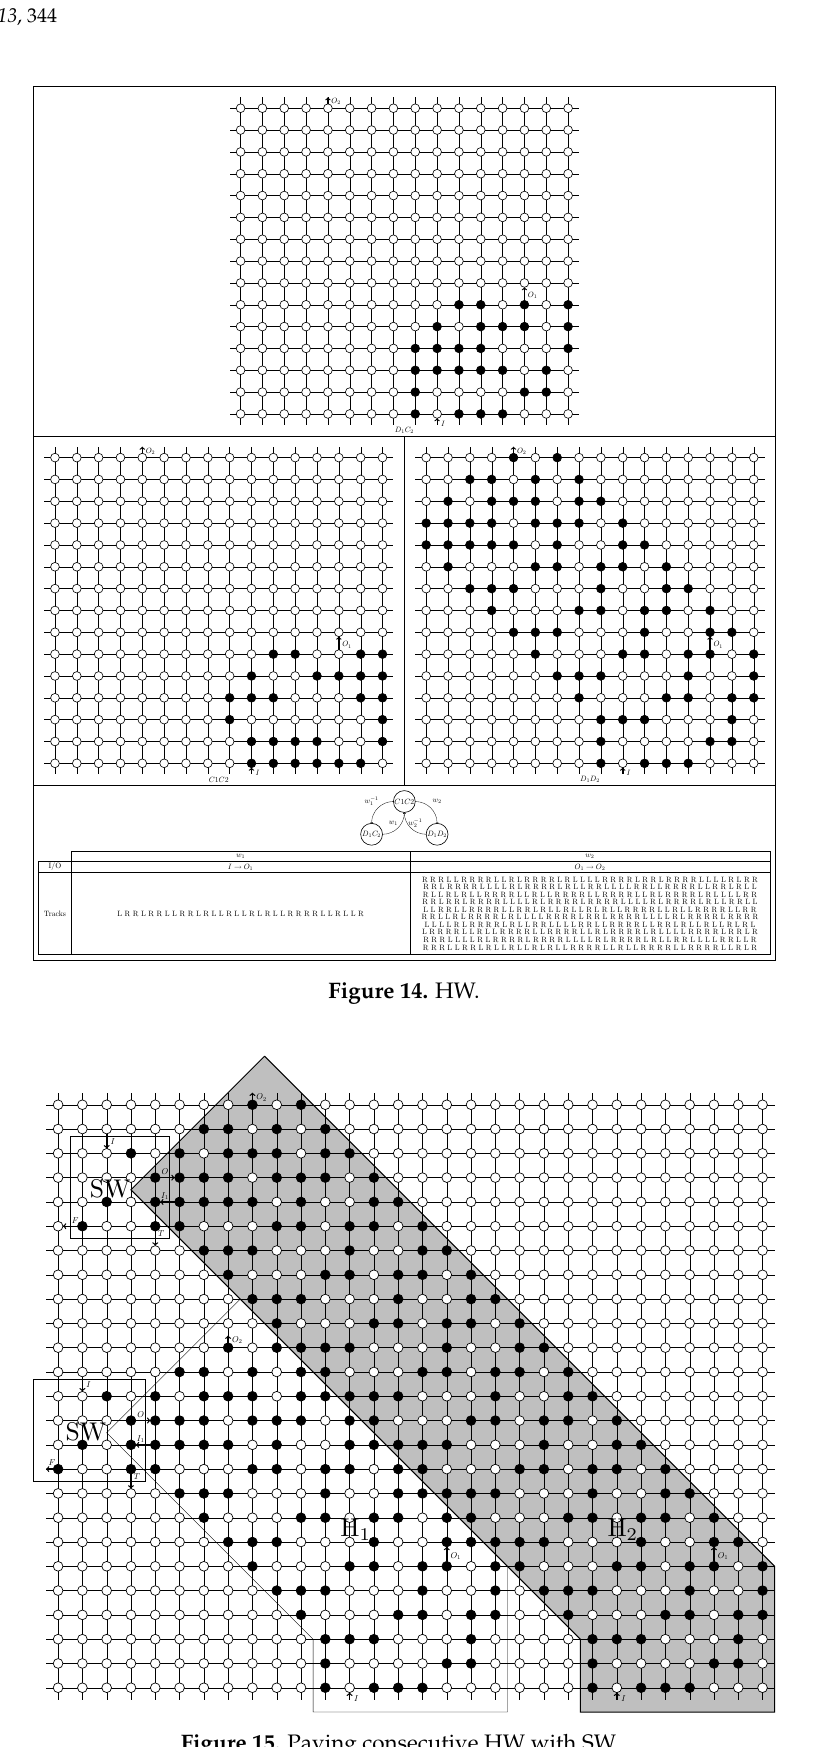
Figure 15. Paving consecutive HW with SW